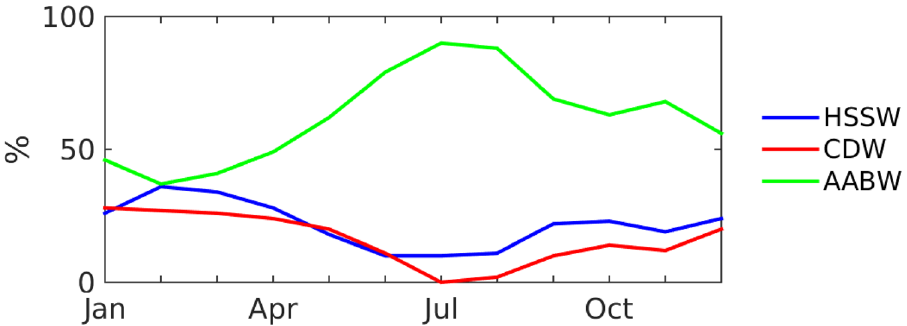
Figure 4. Percentage of water at the bottom sensor of the P2 mooring that can be attributed to HSSW from the Ross Sea (blue), CDW (red) and AABW (green) from further east measured at the bottom sensor of